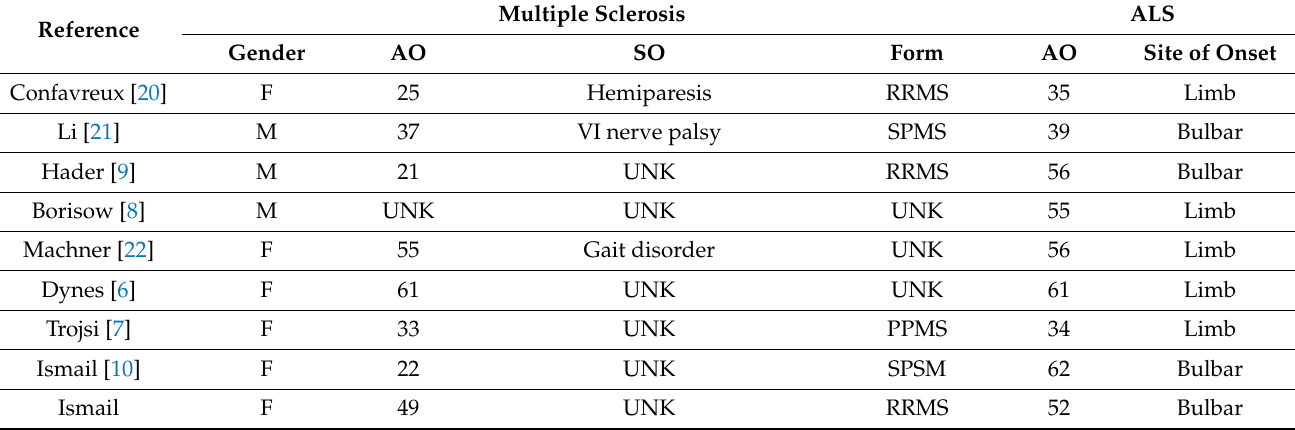
Table 1. Demographics and clinical features of previously described MS-ALS